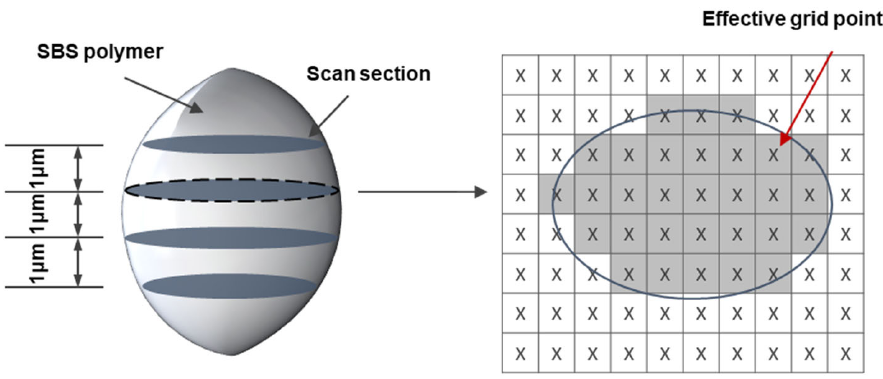
Figure 6. Schematic diagram of effective grid point counting.